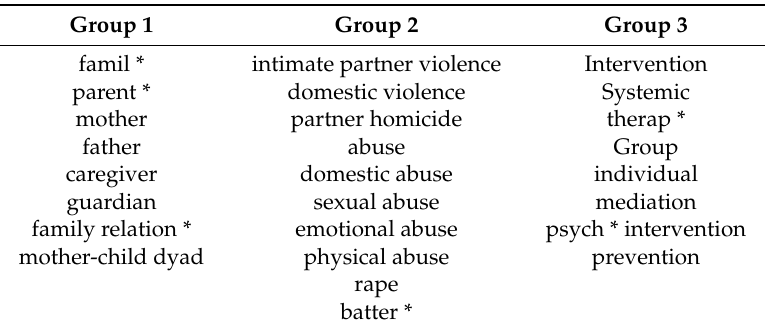
Table A1. Search terms §